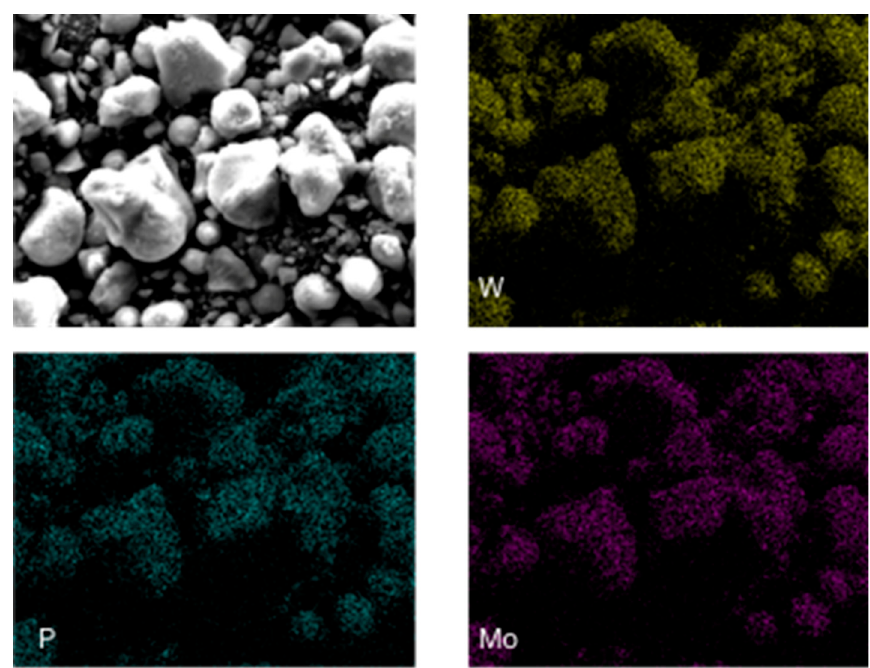
Figure 6. SEM micrographs of H 14 NaP 5 W 29 MoO 110 /Catalox SBa-90, mapping of W, P, and Mo.